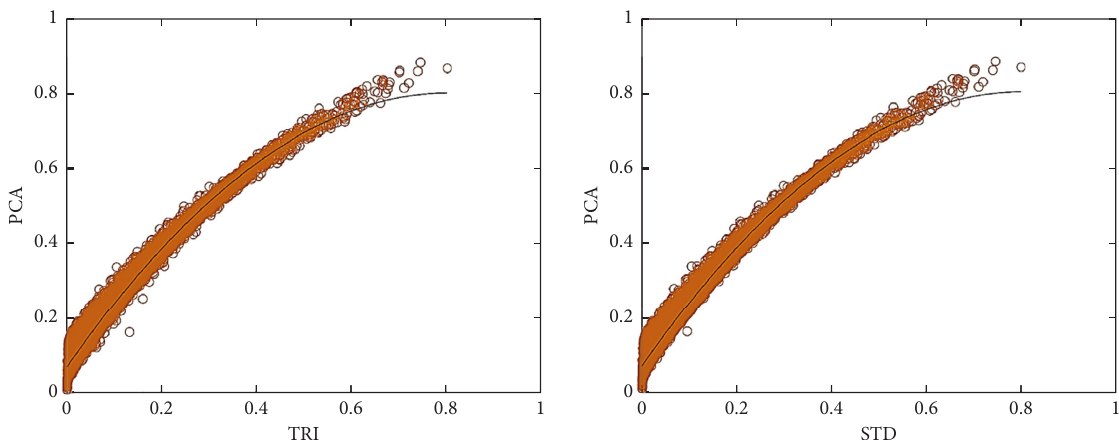
Figure 20: Regression models to transfer TRI and STD to PCA